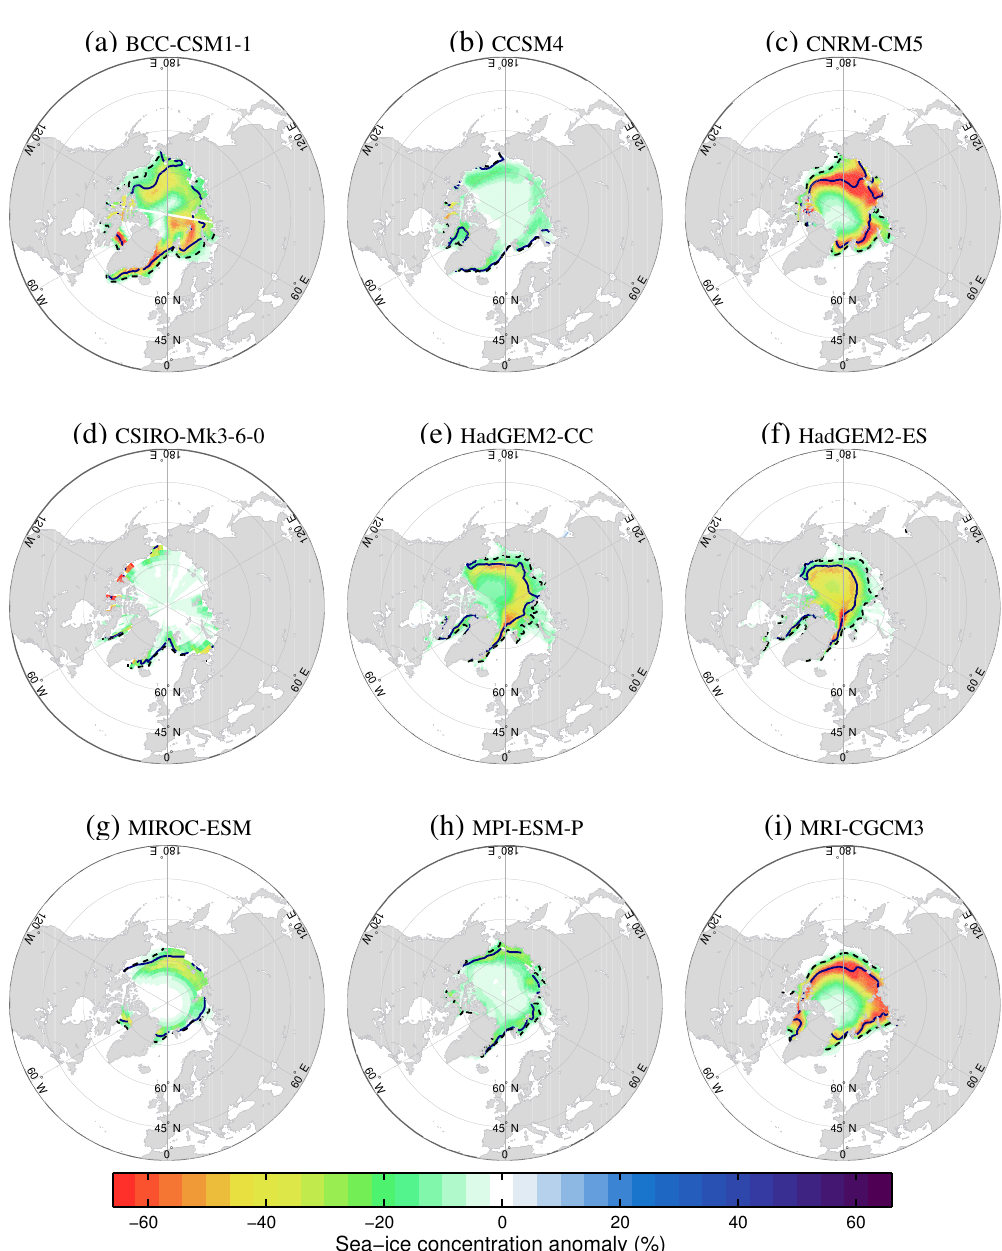
Figure A3. MH summer (September) sea ice concentration anomalies (in %, with respect to the PI reference period) and location of the ice edge for 6ka (solid lines) and for the PI period (dashed lines), defined as 15% concentration